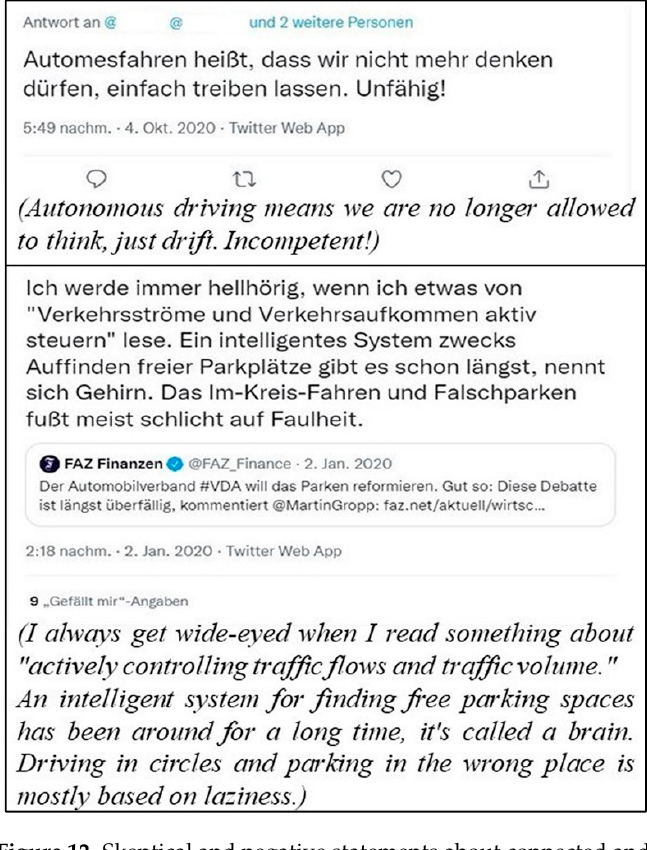
Figure 12. Skeptical and negative statements about connected and automated driving technology.